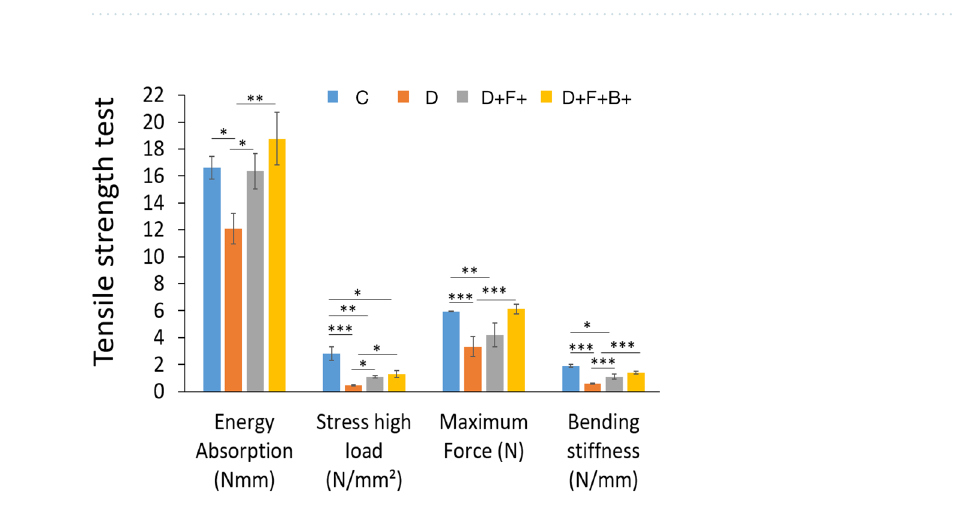
Figure 9. Photomicrograph of the wound healing area following injury stained with H&E (×40). Ne neutrophils, F fibroblasts, B basal cells, V vessel.